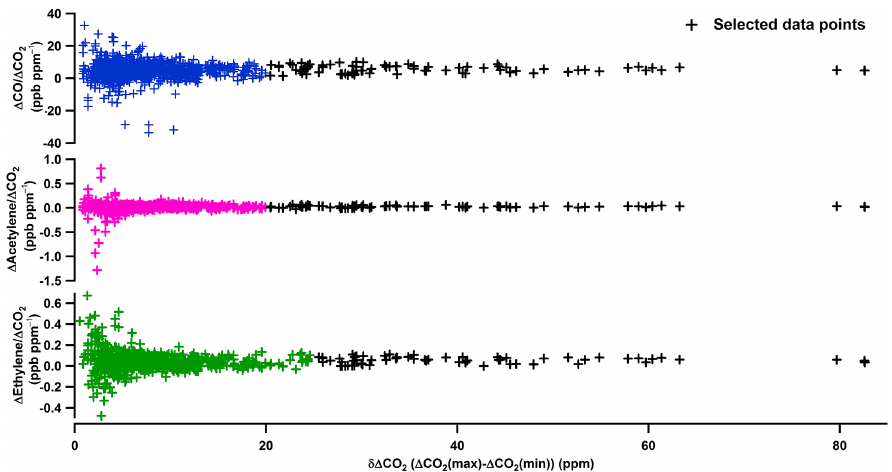
Figure 3. Selected ratios to (cid:49) CO 2 plotted vs. the local CO 2 offset ( δ(cid:49) CO 2 ) from the measurements acquired during the Multi-CO 2 cam- paign. Black data points were selected to determine the equation of the horizontal asymptote using the criteria described in Sect. 3.3.2 (the used criteria depend on the considered